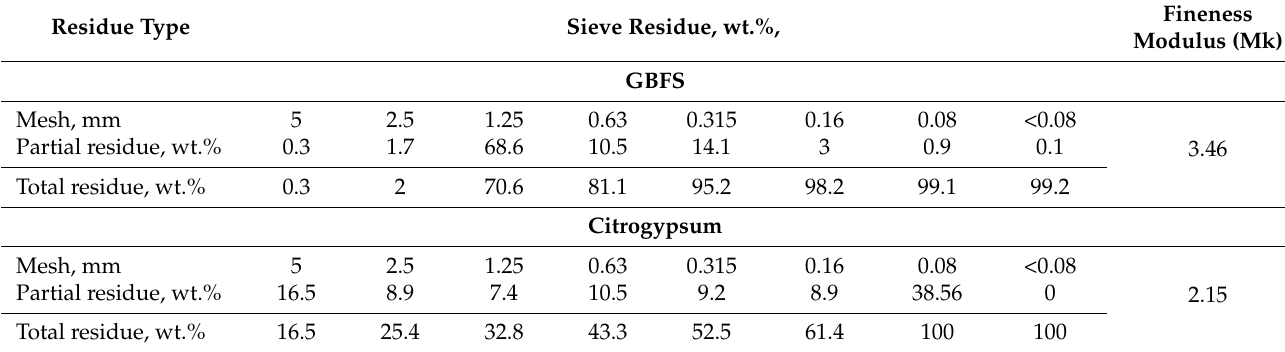
Table 4. Granulometry and fineness modulus of the GBFS and citrogypsum.